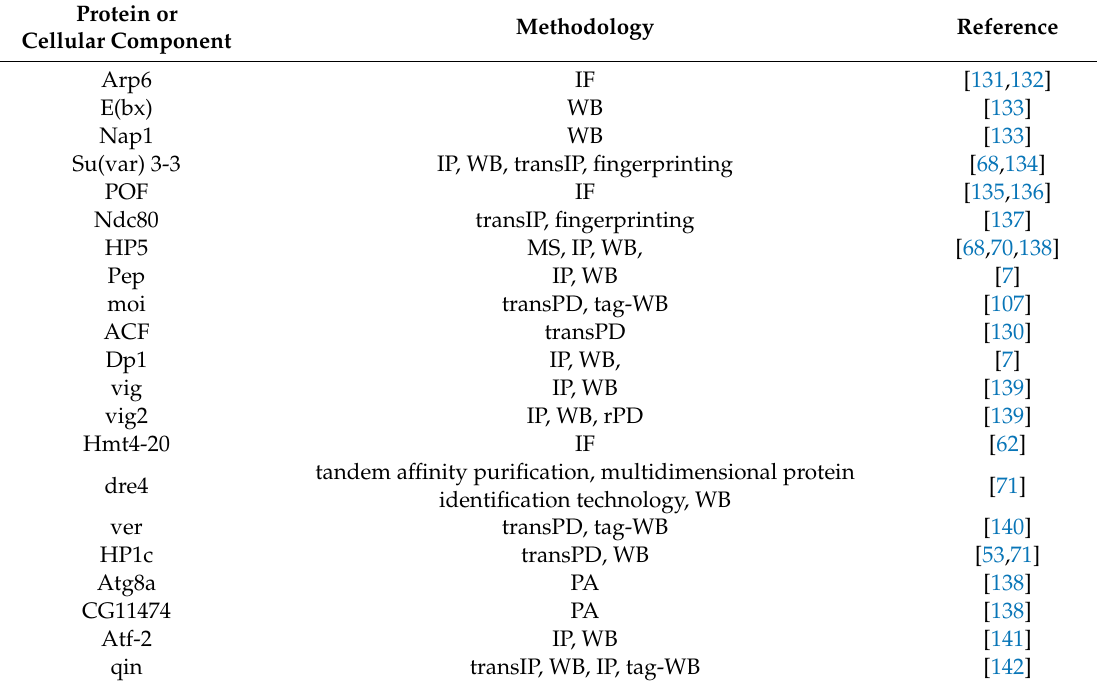
Table 2. HP1a interactors in Drosophila for which the interaction domains within HP1a have not been